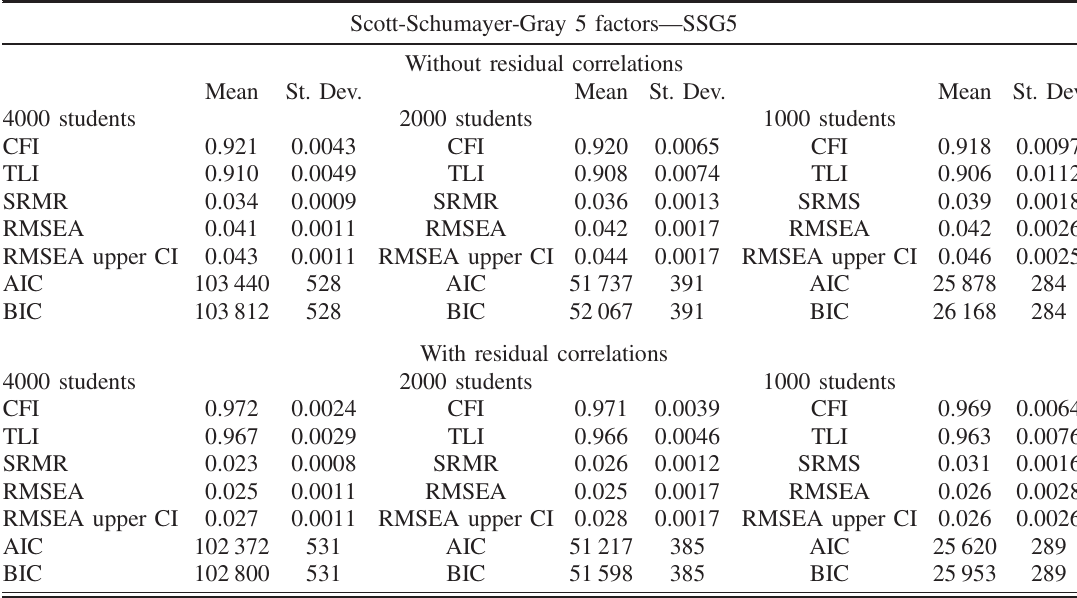
TABLE V. Fit statistics ’ mean and standard deviations of 2000 samples of size 4000, 2000, and 1000 students for the SSG5 model. None of the smaller samples tested had any misfits, which is an indication that this model is considered stable within this study. As the sample sizes get smaller the fit statics get worse, but never get to the point of representing a poor model